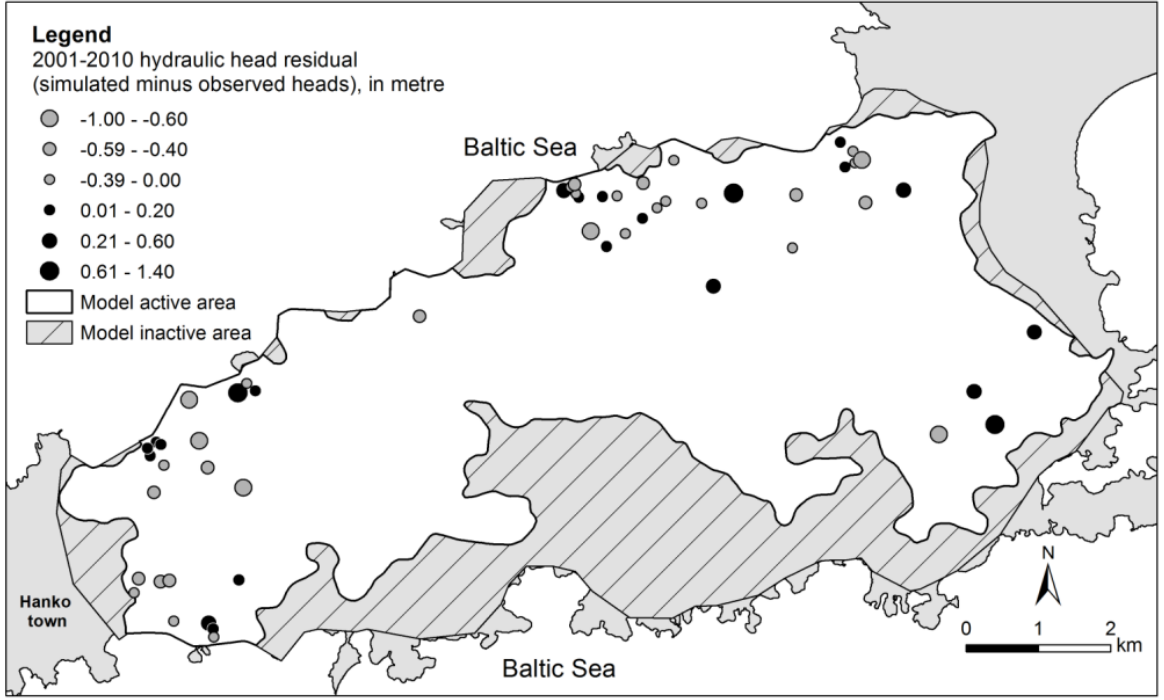
Figure 6. Spatial distribution of mean residuals—differences between simulated and observed heads from observation wells during